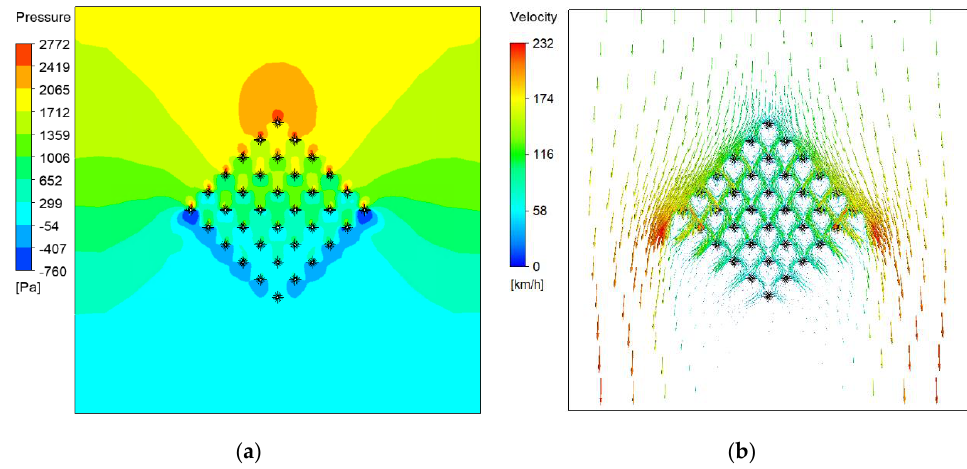
Figure 11. ( a ) Pressure distribution, ( b ) Velocity distribution (s = 500 mm, v inlet = 120 km/h, α = 45 ◦